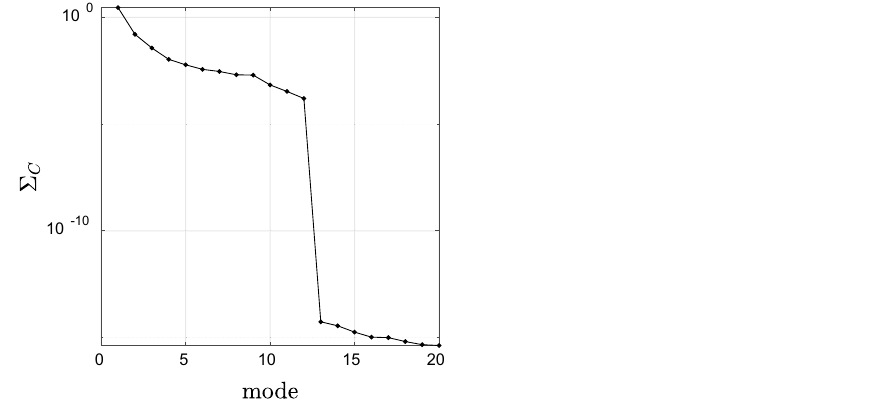
Figure 6. Canonical correlations between CO 2 concentration and EWH anomaly from